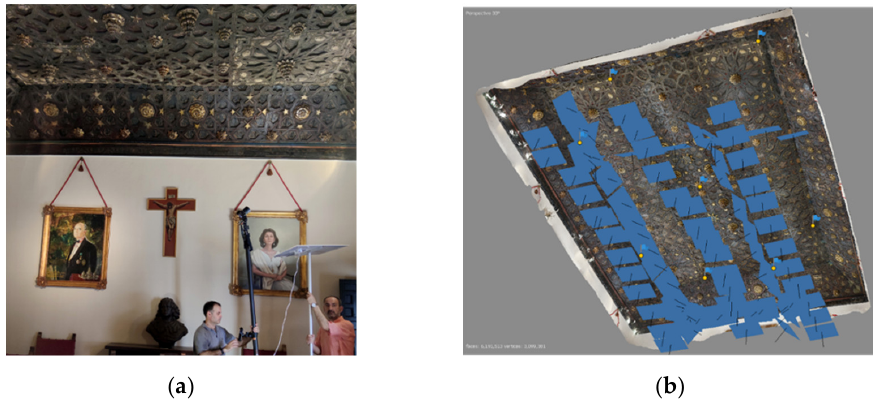
Figure 13. Photogrammetry on the mezzanine: ( a ) Data capture. ( b ) 3D photogrammetric model. The focal length of the camera was set to 28 mm and the resolution to 24.3 Mp for each image. The photograph alignment was computed using Metashape software with the Accuracy parameter set to medium. The dense point cloud was obtained with medium quality that computed 30,957,566 points, and the model mesh was processed setting the Faces count parameter to high, thereby obtaining a total of 6,191,513 faces. Finally, the texture was computed by setting the following parameters: Mapping mode (Generic),